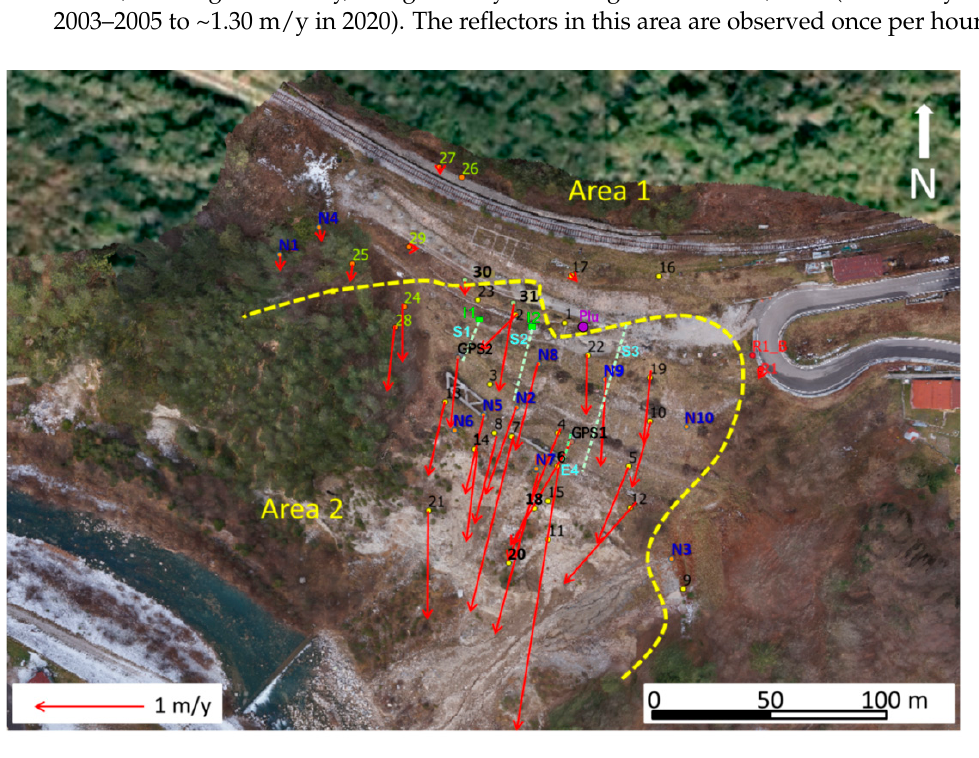
Figure 6. Kinematic areas of Perarolo landslide, positions of retroreflectors and 2018–2020 velocities superimposed to a 2018 orthoimage. The numbers in the figure correspond to the names attributed to the retroreflectors. Table 1. Main data about kinematics of Perarolo landslide for each recognized area: low velocity (i.e., mean velocity without rainfall triggering); peak velocity, fraction of episodes where the velocity exceeds three times the corresponding velocity standard deviation ( 𝑓 (cid:2871)(cid:3097) ), mean velocity in the com- plete time span.